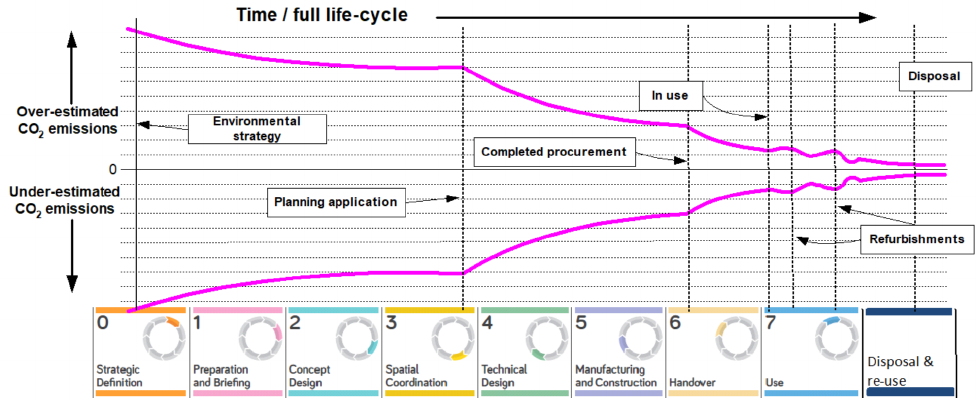
Figure 3. This graph shows the estimating trumpet that is adapted from Estimating Accuracy Trumpet, by R. Max Wideman (accessed on 27 May 2022 from http://www.maxwideman.com/). The graph illustrates how the accuracy of carbon emissions, both embodied and operational, becomes more precise as the life cycle of the building